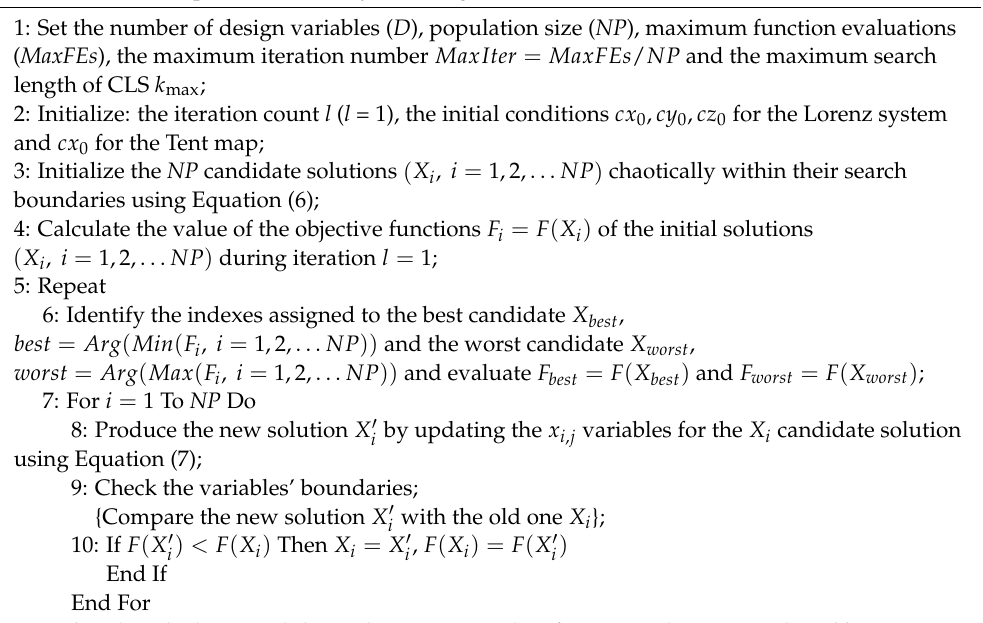
Algorithm 1: The procedure of CJaya-SQP